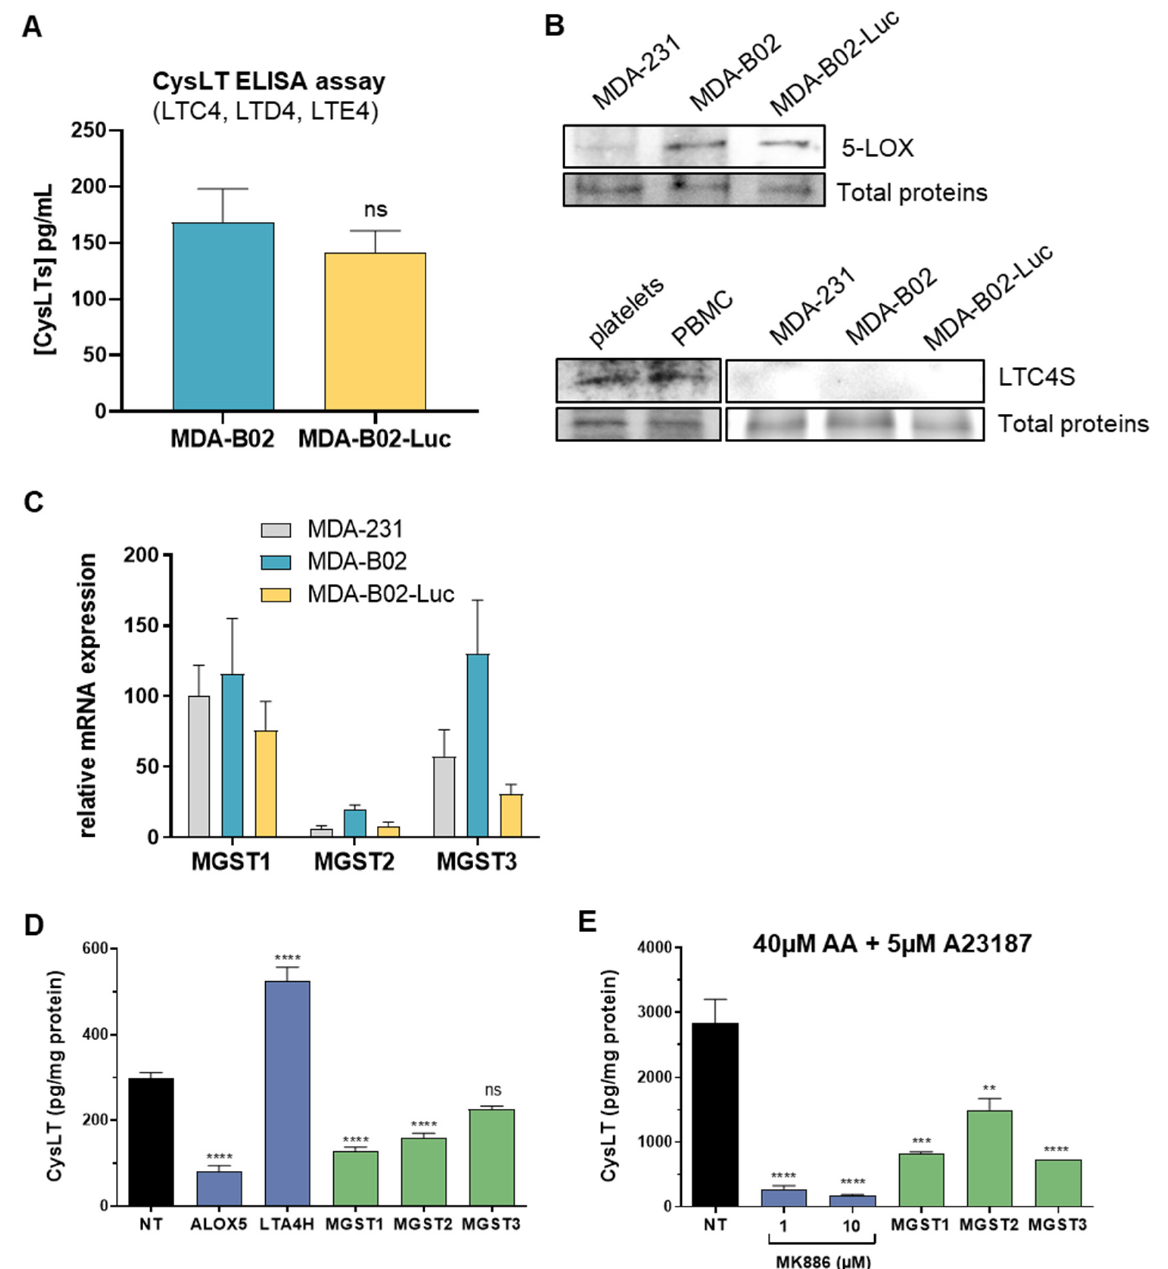
Figure 2. MDA-B02 breast cancer cells produce CysLT via MGST enzymes in absence of LTC4S. ( A ) The presence of secreted CysLT (LTC4, LTD4, LTE4) in the conditioned media of MDA-B02 and MDA-B02-Luc cells was analyzed using an ELISA assay. ( B ) 5-Lipoxygenase (5-LOX) and LTC4 synthase (LTC4S) were analyzed in the two MDA-B02 cell lines and in their parental MDA-231 cell line using western blotting assays. ( C ). RT-qPCR analysis of the three microsomal glutathione S-transferase enzymes (MGST1/2/3). ( D ) CysLT secreted in the conditioned media of MDA-B02 cells transfected with siRNA targeting the leukotriene pathway or MGST1/2/3 were analyzed by ELISA assay. ( E ) MDA-B02 cells treated with the leukotriene biosynthesis inhibitor MK886 or transfected with siRNA targeting MGST1/2/3 were stimulated with 40 µ M arachidonic acid (AA) and 5 µ M calcium ionophore A23187 for 30 min before analyzing the secreted CysLT using ELISA assay. (ns = not significant; ** p < 0.05; *** p < 0.001; **** p < 0.0001; vs. NT; one-way ANOVA). Abbreviations: AA = arachidonic acid; CysLT = cysteinyl leukotriene; PBMC = peripheral blood mononuclear cell.